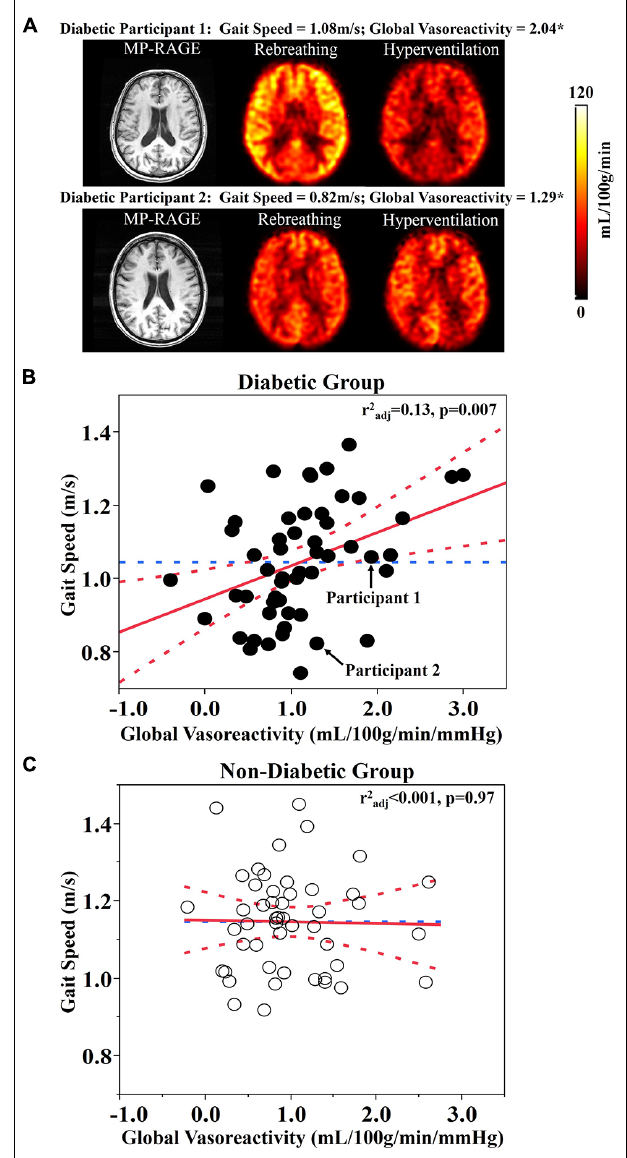
FIGURE 1 | (A) Reconstructed anatomical (i.e., MP-RAGE) and perfusion maps for two participants with type 2 diabetes mellitus.The top row represents a participant with diabetes that has high global vasoreactivity and fast gait speed (see Diabetic Participant 1 in A ).The bottom row represents a participant with diabetes that has low global vasoreactivity and slow gait speed (see Diabetic Participant 2 in A ). (B) The relationship between global vasoreactivity and gait speed in the diabetic group. (C) The relationship between global vasoreactivity and gait speed in the non-diabetic group.Vasoreactivity was calculated as the change in perfusion from hypocapnia (hyperventilation) to hypercapnia (CO 2 rebreathing) conditions, normalized to the change in CO 2 values. Best fit – red solid line; Confidence Intervals – red dotted lines; Gait speed mean – blue dotted line; *unit – mL/100g/min/mmHg.